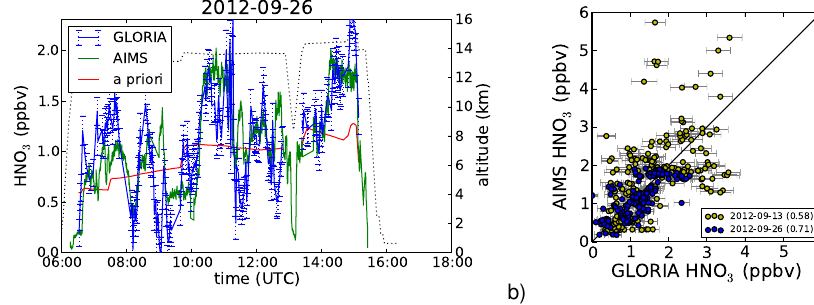
Figure 10. Comparison of retrieved HNO 3 125 m below flight level and HNO 3 measured by AIMS. See also Fig. 7 and Table 5. On 23 September 2012, AIMS has been operated in the water vapour mode, therefore no HNO 3 data are available for that flight.